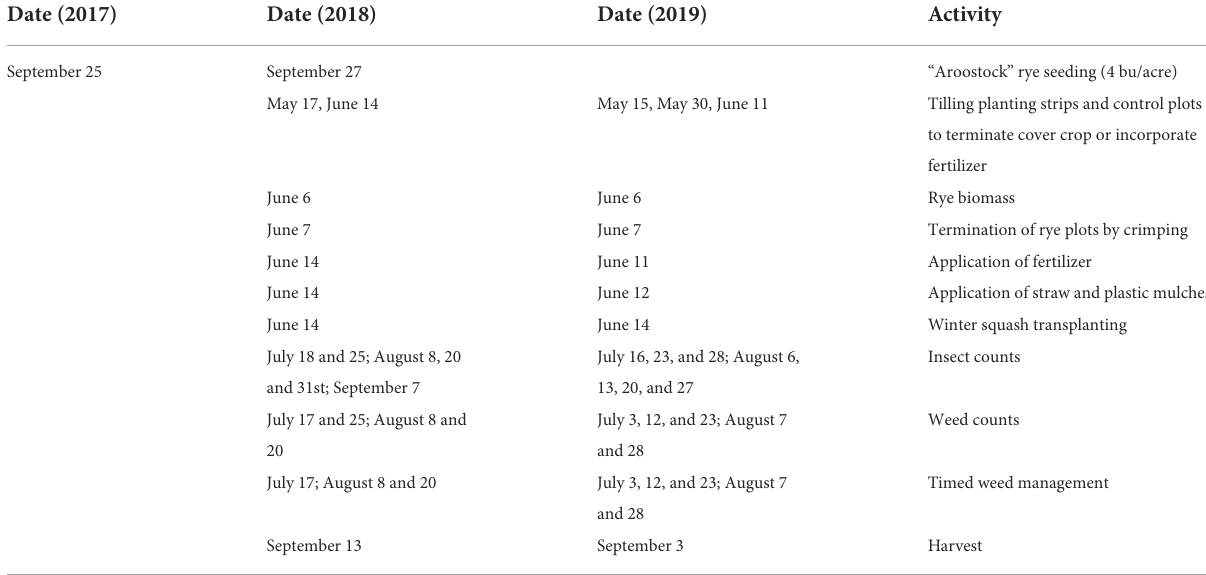
TABLE 1 Summary of field activities for CCBRT management of organic squash, 2018 and